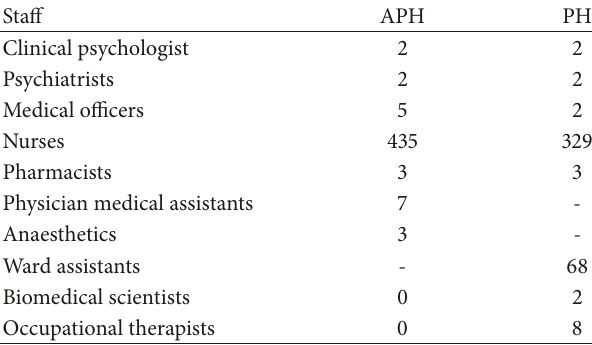
Table 1: Staff distribution at Accra Psychiatric Hospital and